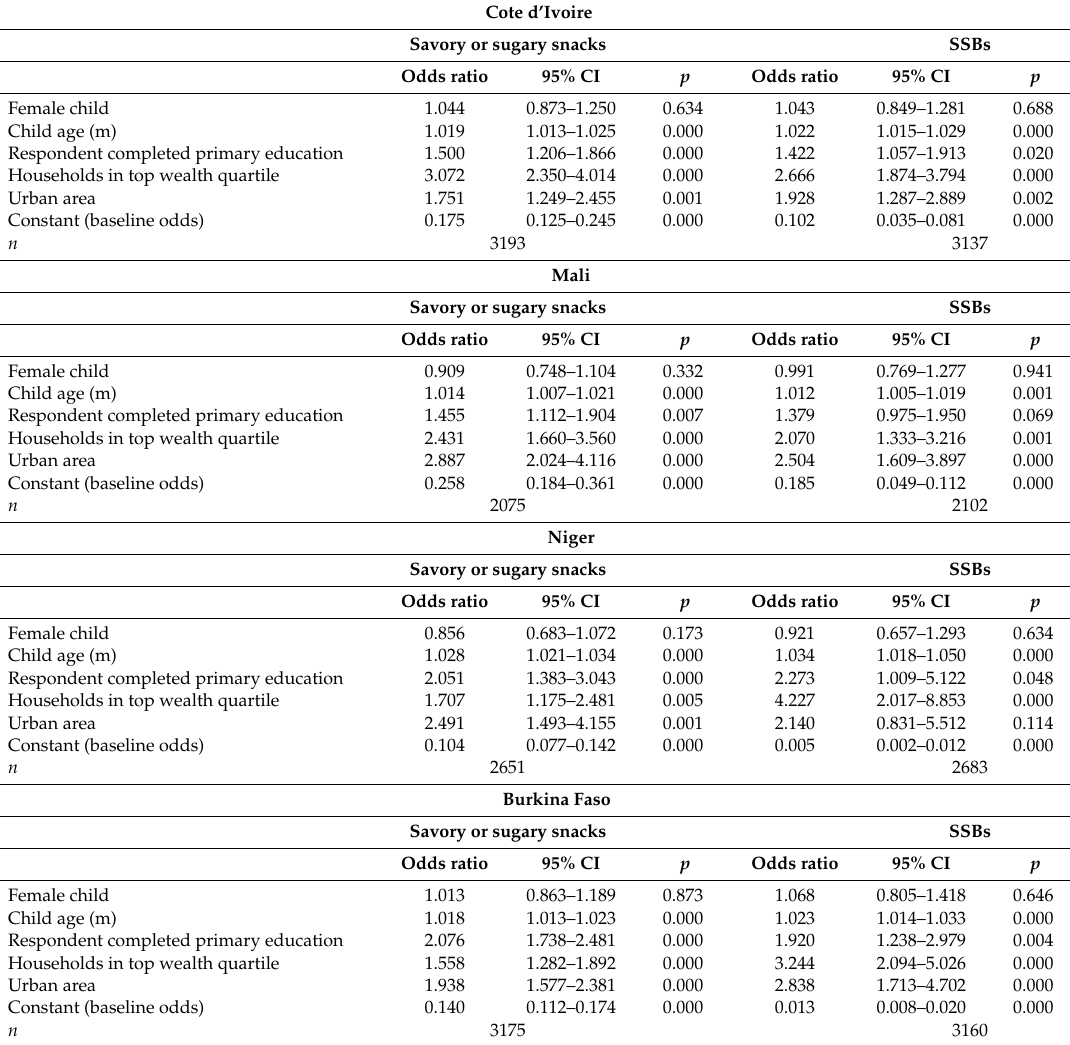
Table 5. Results of multivariate logistic regressions predicting children’s snack consumption, past 24